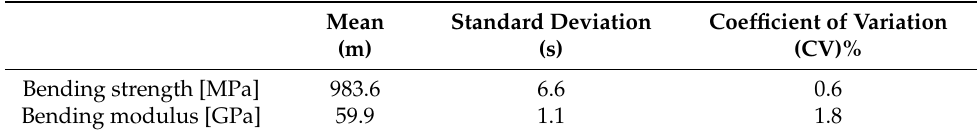
Table 5. The statistical indicators determined after the three-point bending tests of the A6 steel specimens.